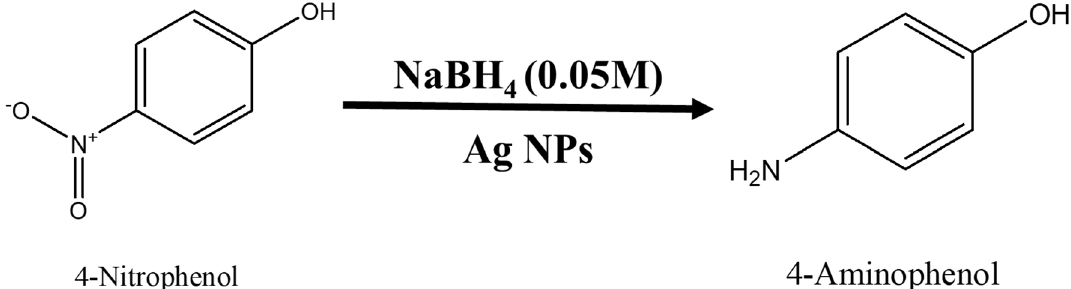
Figure 13. Schematic chemical reaction of conversion of 4-nitrophenol into